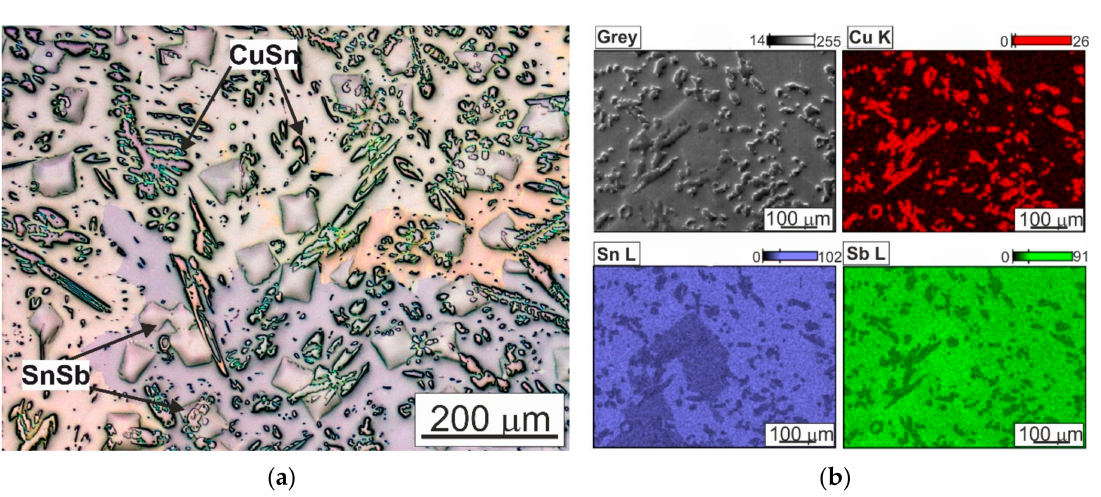
Figure 3. Microstructure of SnSb11Cu6 alloy in initial state after casting; ( a ) photo taken using a light microscope; ( b ) microstructure and maps of distribution of elements: Cu, Sn, Sb;